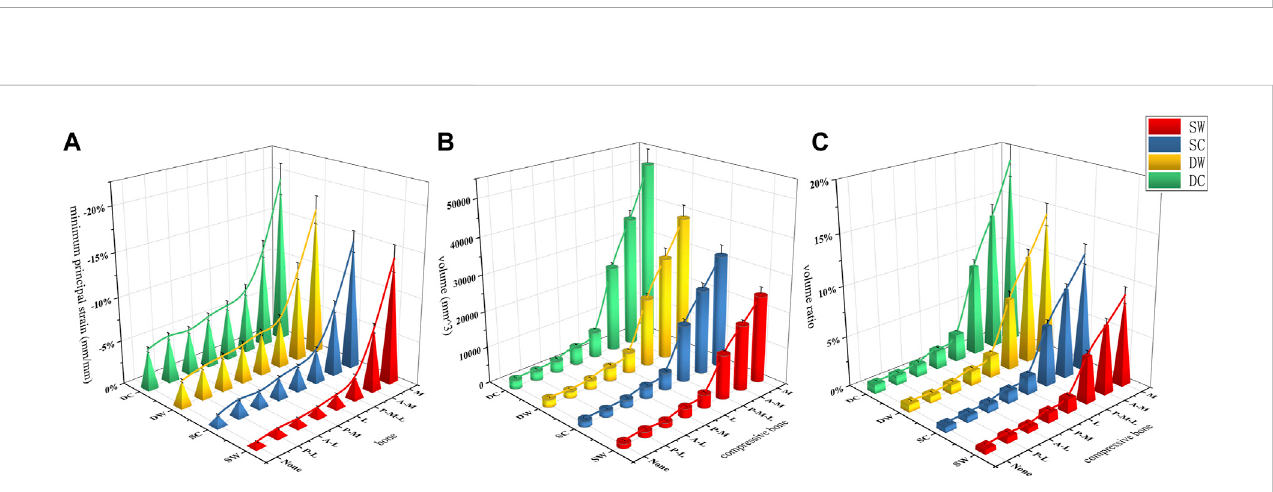
FIGURE 9 The minimum principal strain and nephograms ofthe proximal fracture models under thedynamicclimbing hip contact loads wereexhibited. The order was the same as it was in Figure 4. From images (A – H) , the least value of each bone model gradually decreased and the lowest one of − 0.19356 appeared in (H) . The elements with the values below the cut-off of − 0.009 were marked in dark gray.